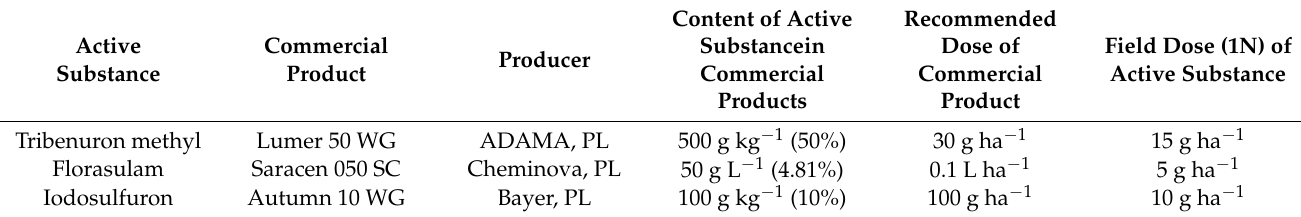
Table 1. Description of herbicides used in the biological